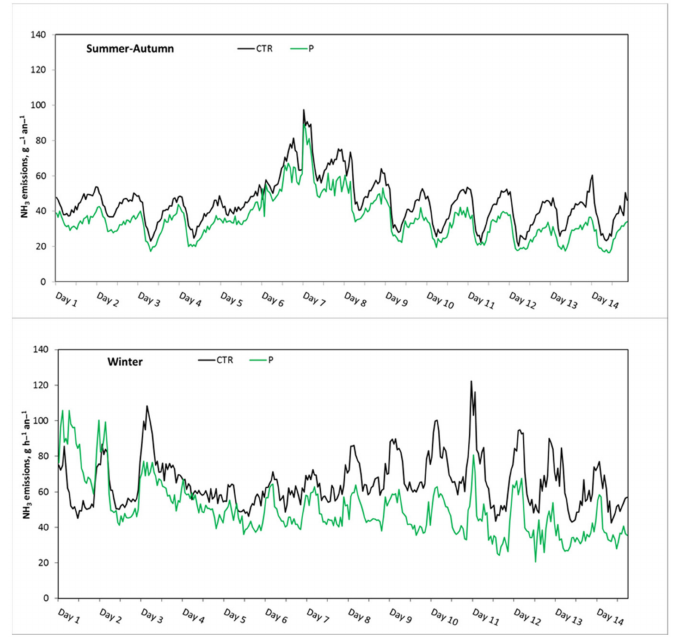
Figure 5. NH 3 emissions in the compartments CTR and P in the two measuring periods (summer– autumn and